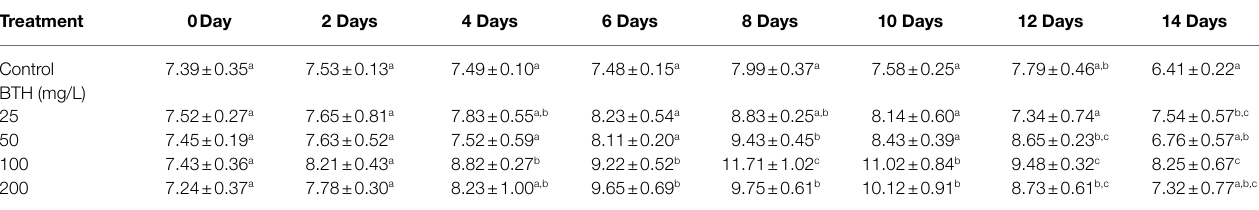
TABLE 2 | Effects of BTH treatment at different concentrations on ascorbic acid (AsA) content in R. roxburghii fruit. Treatment